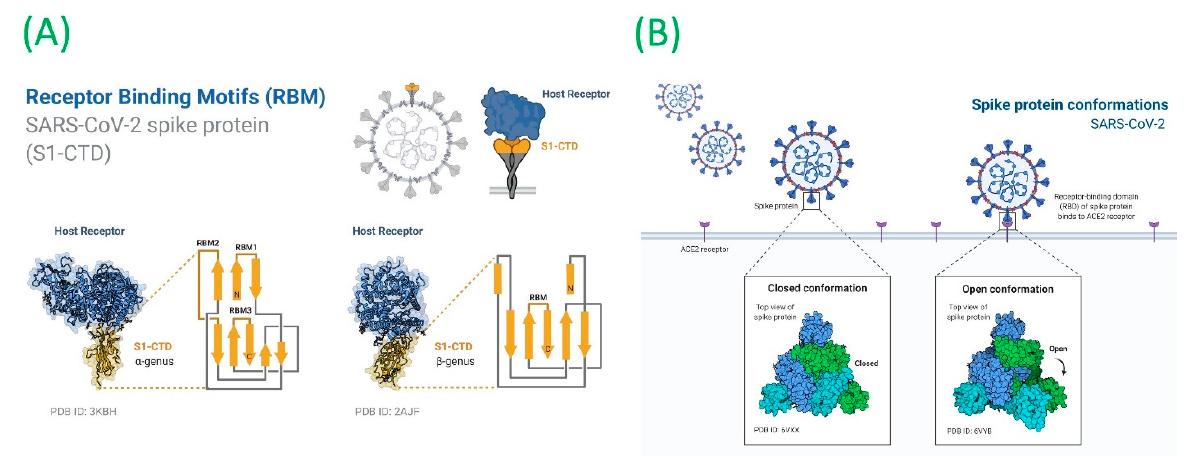
Figure 1. ( A ) Receptor-binding motifs of the severe acute respiratory syndrome coronavirus 2 (SARS-CoV-2) spike protein and its conformation. ( B ) Binding of spike and ACE2. Images were created using BioRender.com (accessed on 16 January 2022).